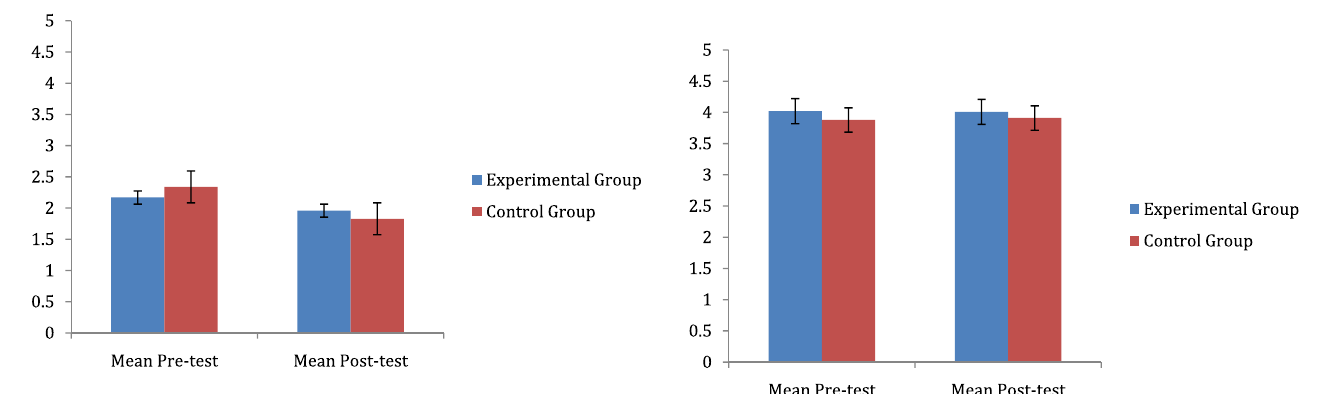
FIG. 3. Calgary study. Mean pre- and post-score of source of knowledge authority factor for experimental and control groups with 5% error bars. (Low score is more expertlike reasoning.)